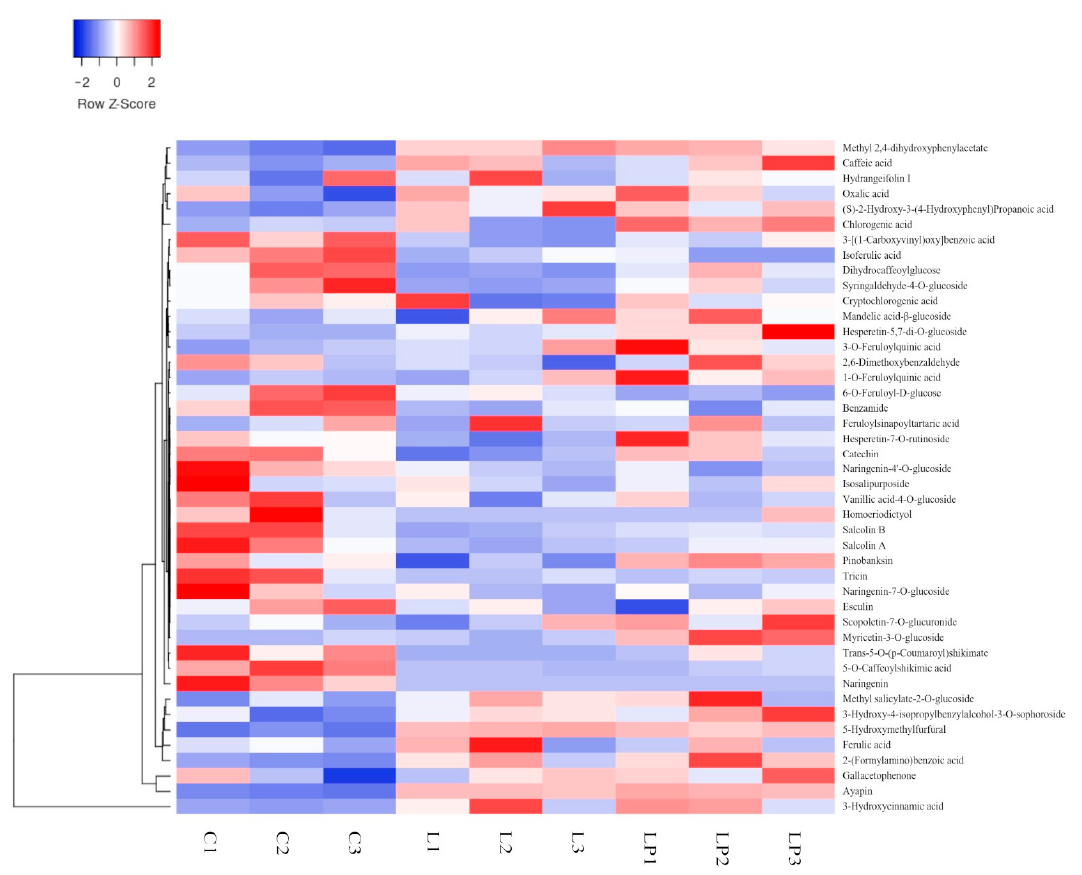
Figure 17. Heatmap and dendrogram of phenols metabolites in embryos of maize under exogenous proline and low-temperature stress treatments. Vitamins and Other Metabolites